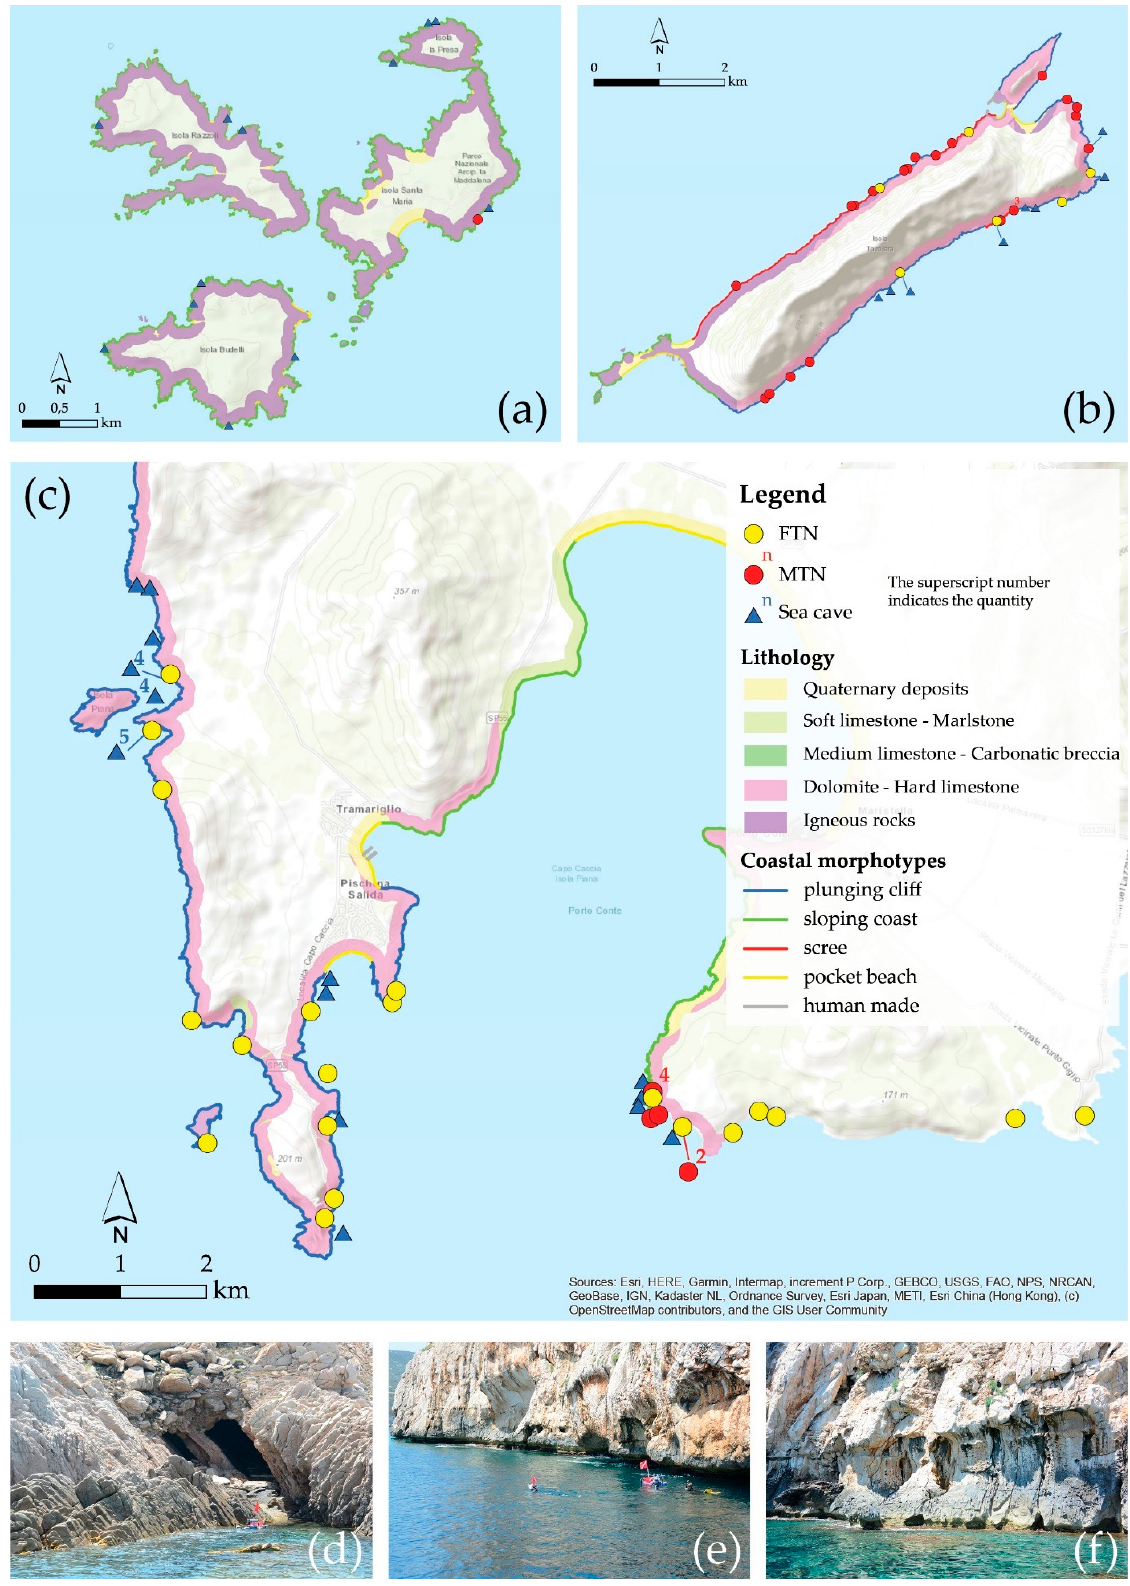
Figure 7. Maps of coastal morphotypes and surveyed geomorphological structures at ( a ) Razzoli, Budelli, and Santa Maria islands, ( b ) Tavolara, and ( c ) Capo Caccia; ( d ) sea cave at Razzoli, ( e ) MTN at Capo Caccia; ( f ) MTN and FTN near a sea cave at Tavolara.